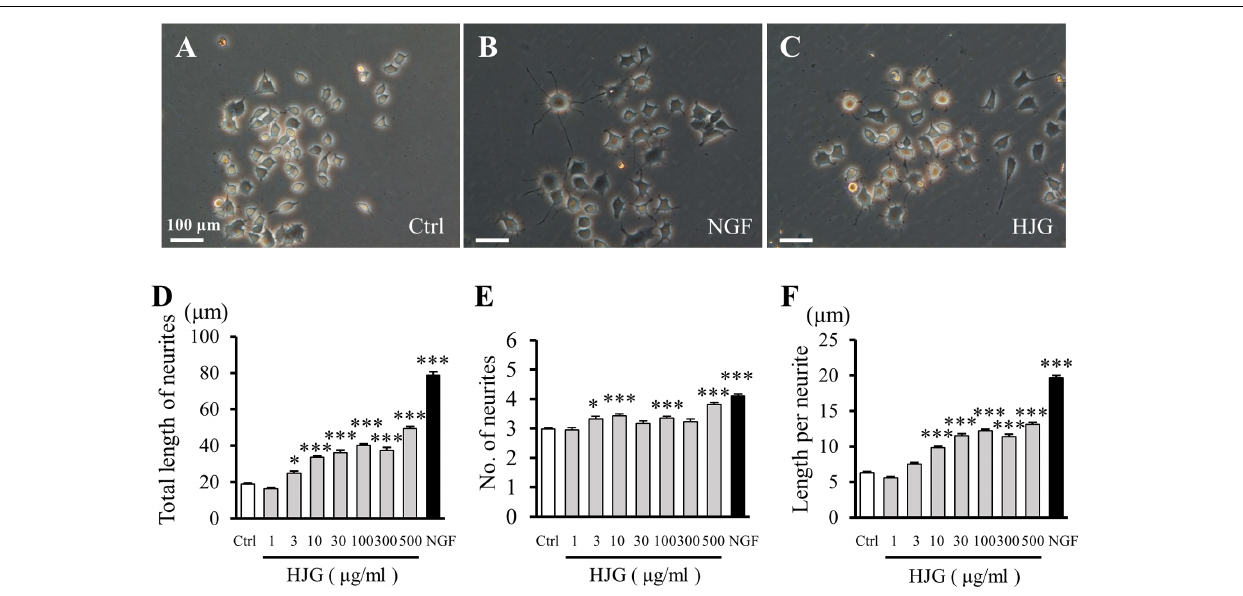
FIGURE 1 | Effects of HJG on neurite outgrowth of PC12 cells. PC12 cells were cultured for 72 h in normal medium (A) , medium with 50 ng/ml NGF (B) , or 500 µ g/ml HJG (C) , and morphological appearance was then observed. Scale bar = 100 µ m. Total length of neurites (D) , numbers of neurites (E) , and length per neurite (F) were analyzed as described in the Section “Materials and Methods”. Data represent mean ± SEM from three independent experiments. ∗ p < 0.05 and ∗∗∗ p < 0.001 represent significant differences compared with control (ANOVA followed by Dunnett’s test).